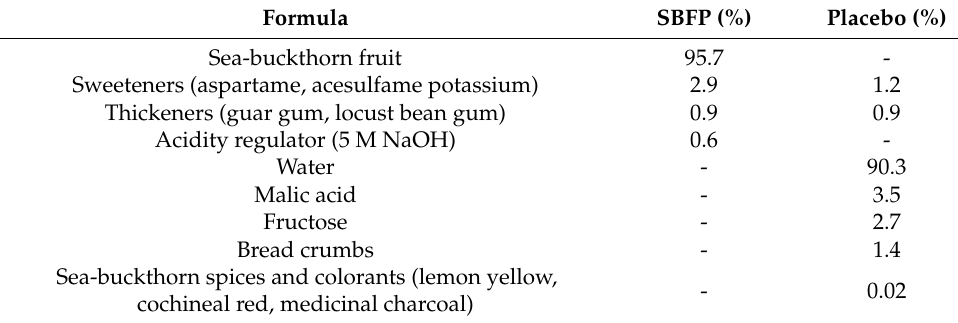
Table 2. Formulae of sea-buckthorn fruit puree (SBFP) and